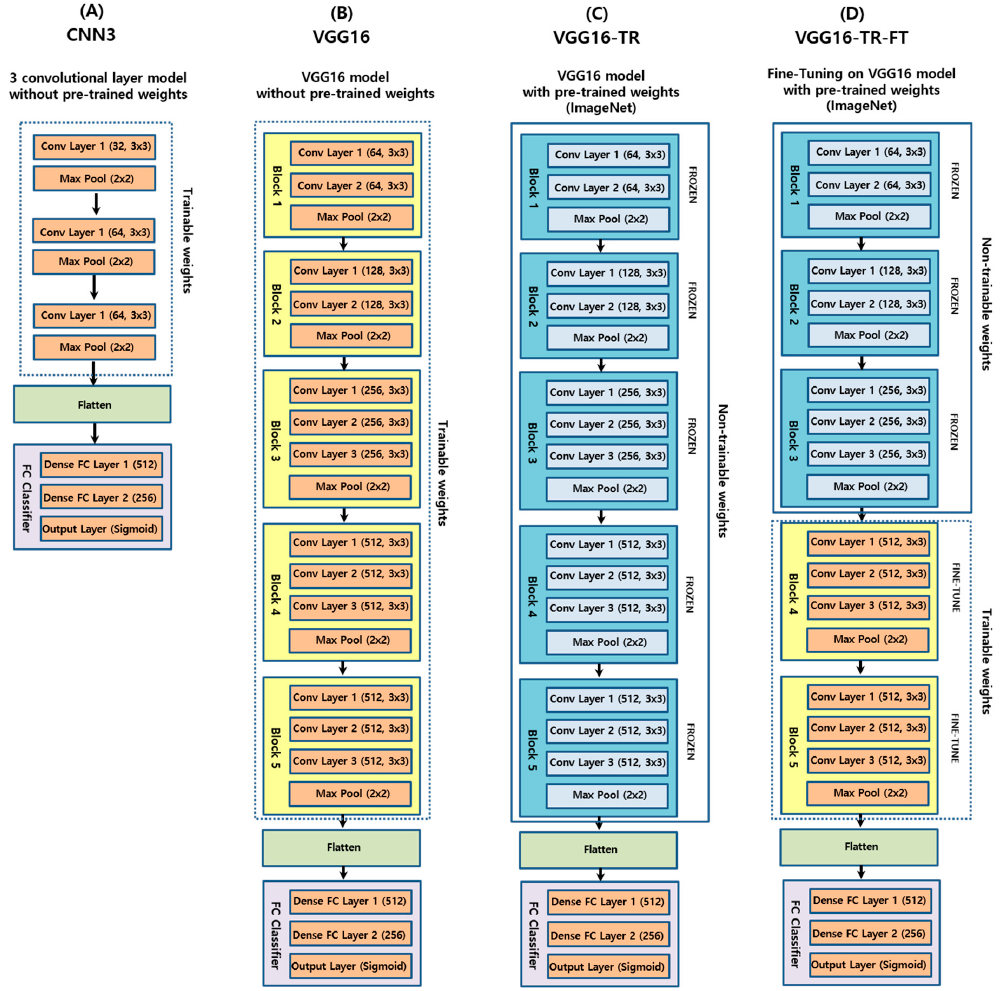
Figure 2. Schematic diagrams of the four convolutional neural networks (CNN) architectures evaluated in this study.